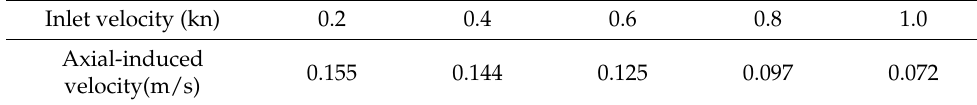
Table 6. The axial induction velocity at different